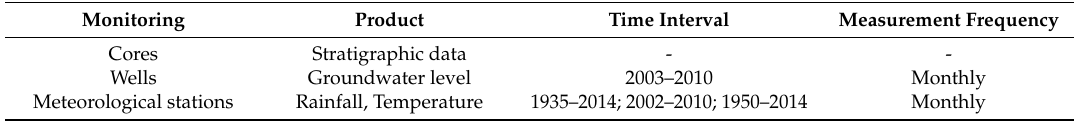
Table 2. Ground-based